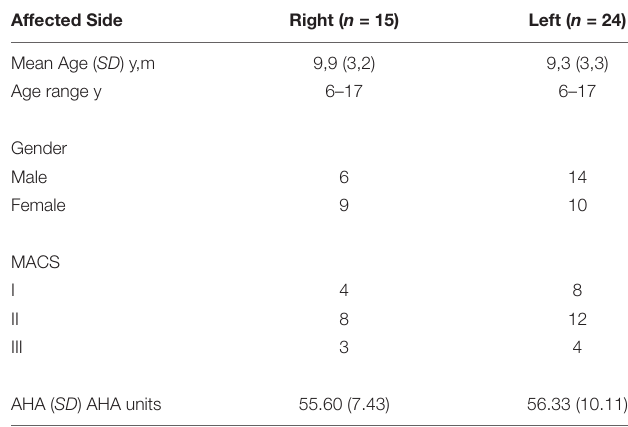
TABLE 1 | Participant